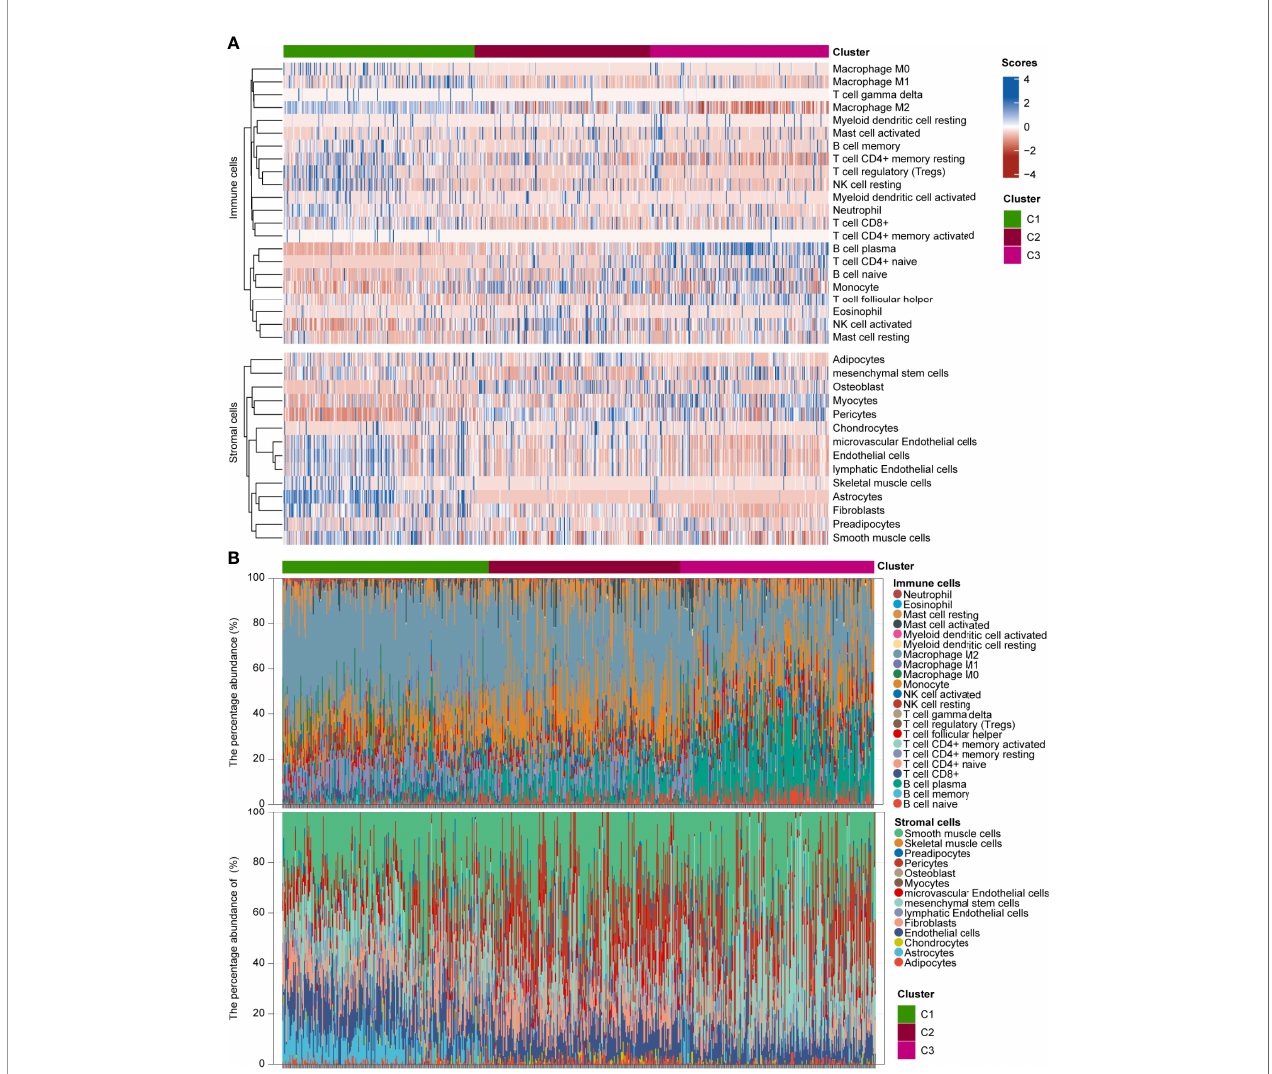
FIGURE 4 | In fi ltration estimations of GAICs and GASCs in three glioma pyroptosis subtypes. (A) Heatmap depicting proportion and subtypes of in fi ltrating GAICs and GASCs in the three pyroptosis subtypes. (B) Stacked plot of the percentage abundance of in fi ltrating GAICs and GASCs for each